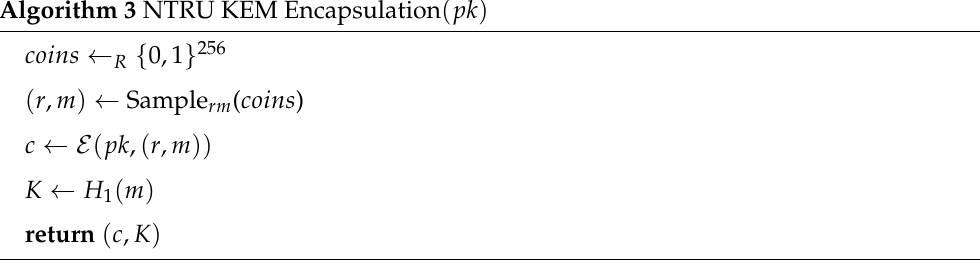
Algorithm 3 NTRU KEM Encapsulation ( pk )